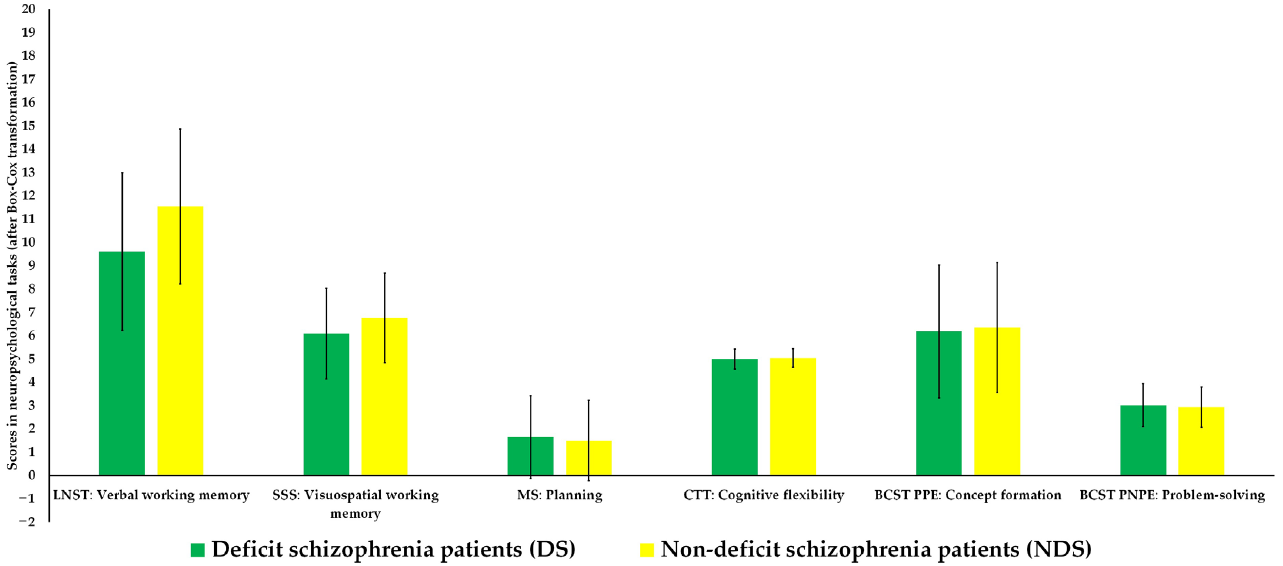
Figure 2. Comparison of executive function profiles between participants from the two clinical groups (scatter bars present SD). BCST = Berg Card Sorting Test; CTT = Color Trail Test; LNST = Letter Number Span Test; MS = Mazes Subtest; SSS = Spatial Span Subtest.